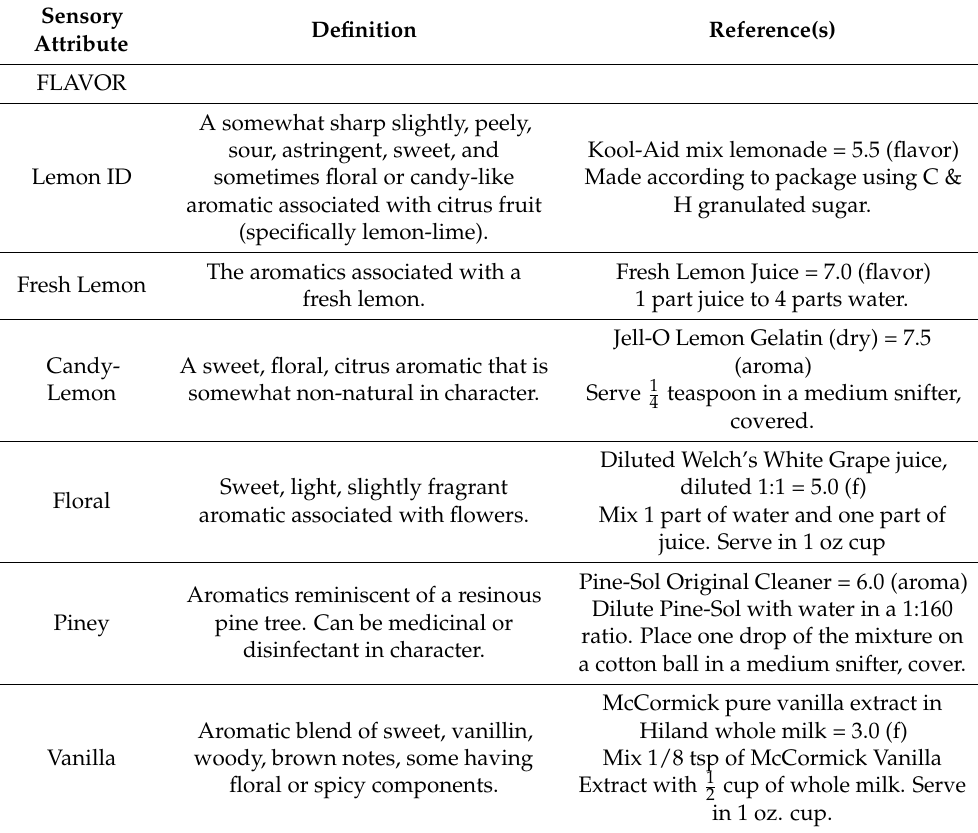
Table A1. Sensory Characteristics and their definitions and references used in this